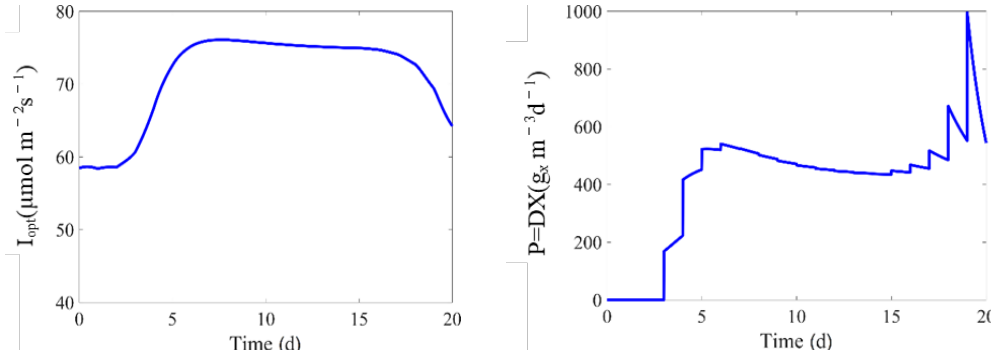
Figure 7. Physiological parameter and productivity simulation results from the identified model with NMPC manipulating photon flux density ( 𝐼 0 ) and dilution rate ( 𝐷 ).